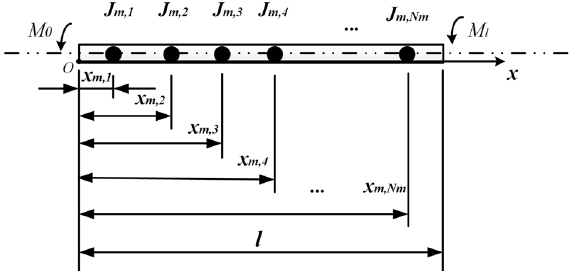
Figure 1. Physical model (This figure was created via Visio 2013, http:// sj. njlhw lc. cn/ pg/ 178. html, Figs. 2, 3, 4, 5, 12 and 21 were also created by